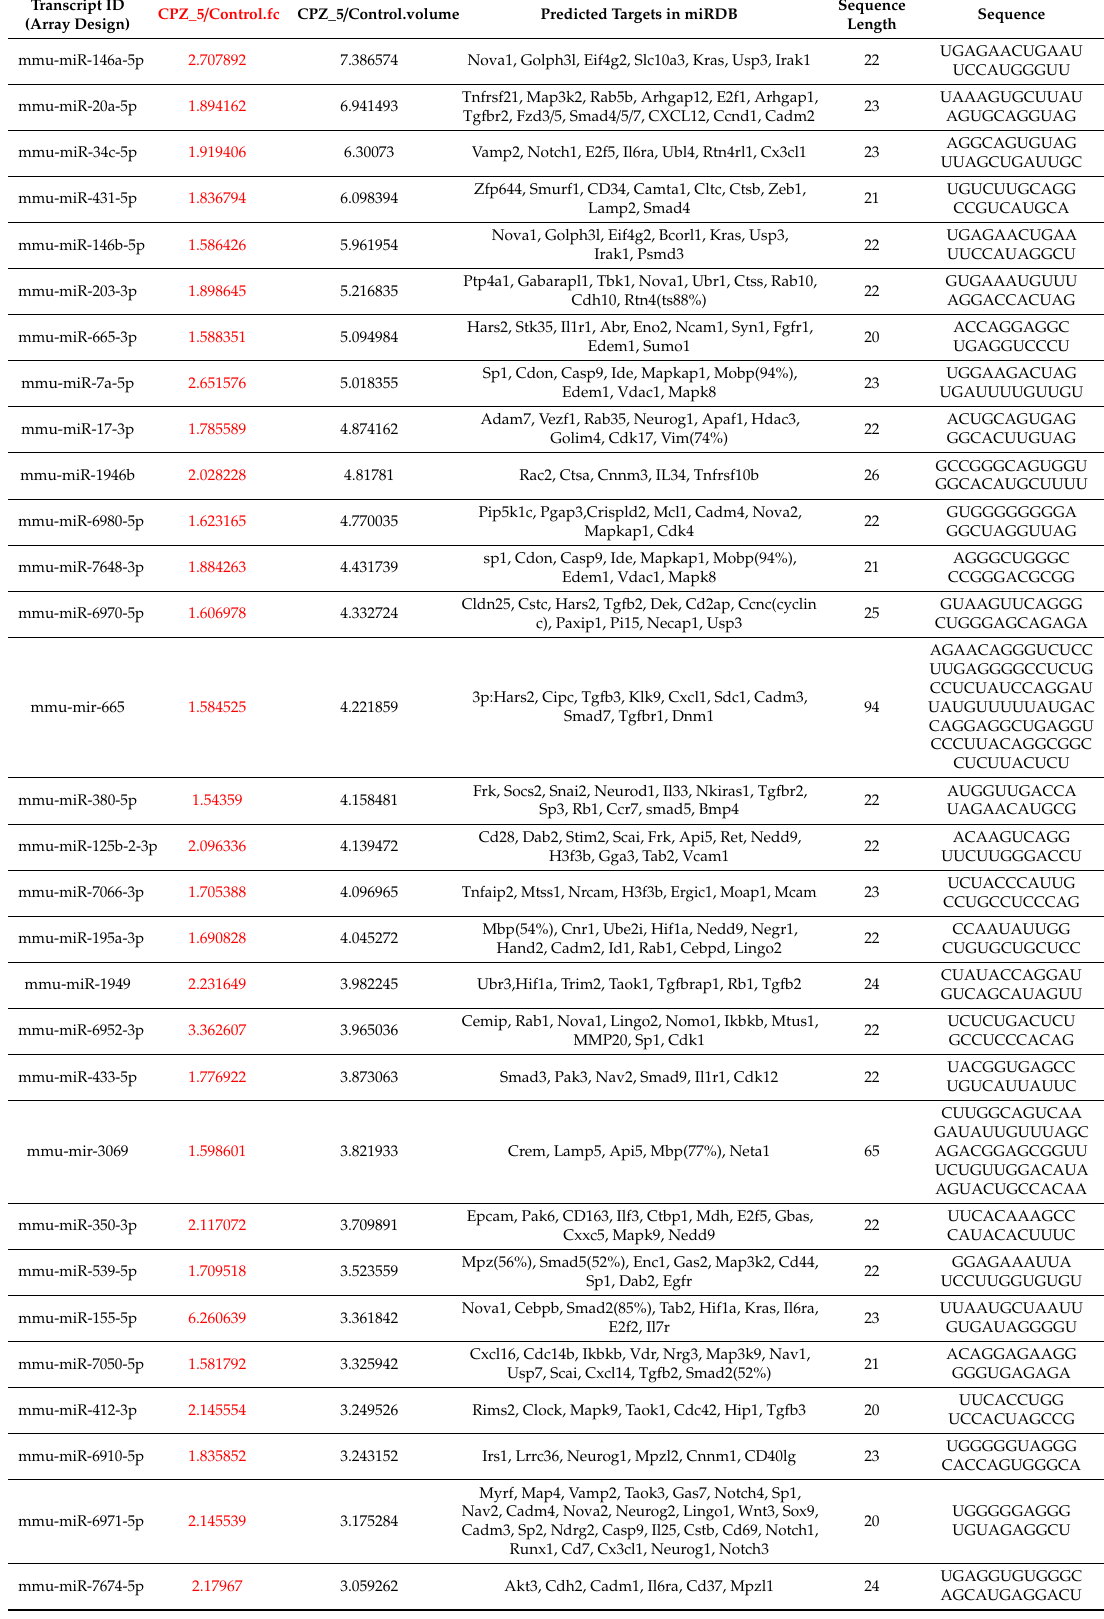
Table 1. Upregulated miRNA in a cuprizone-induced demyelination mouse model (Fold Change ≥ 1.5). Transcript ID / Control.fc CPZ_5 / Control.volume Predicted Targets in miRDB Sequence (Array Design) CPZ_5